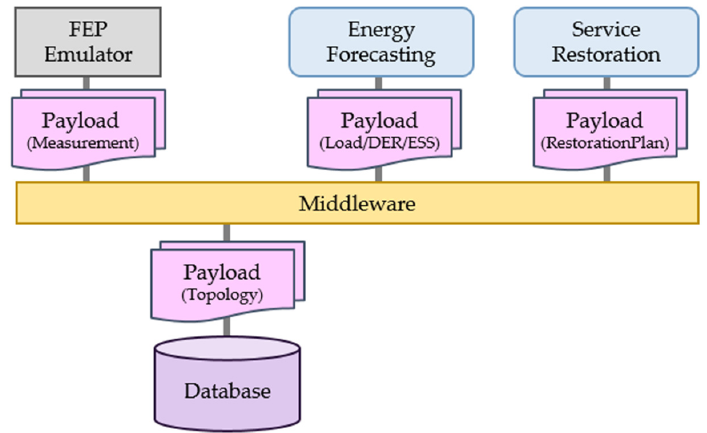
Figure 18. CIM-based data transfer through middleware. Table 3. Data size and speed by interface.